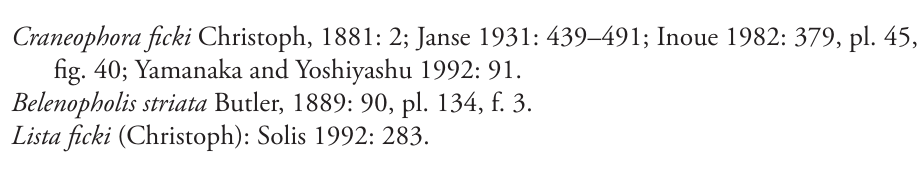
fig. 40; Yamanaka and Yoshiyashu 1992: 91. Lista ficki (Christoph): Solis 1992: 283. Diagnosis. The species is different from congeners by paler scales on the forewing, the tip of the gnathos without denticulation, and the juxta swollen, the apex bifurcated with two pointed